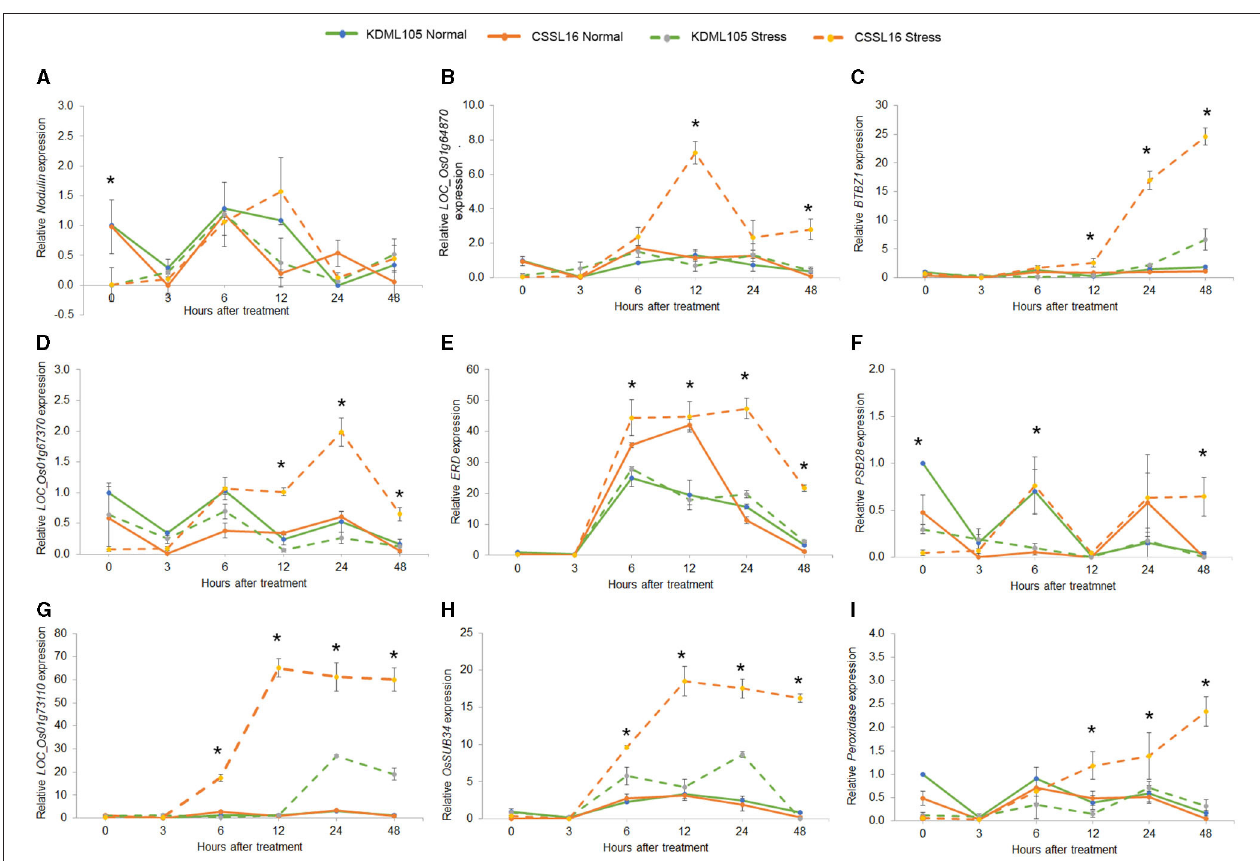
FIGURE 9 | Gene expression analysis of nine candidate genes, Nodulin (A) , Os01g64870 (B) , BTBZ1 (C) , Os01g67370 (D) , ERD (E) , PSBS28 (F) , Os01g73110 (G) , Sub34 (H) , and Peroxidase (I) in CSSL16 and KDML105 under normal and salt stress conditions after 0, 3, 6, 9, 12, 24, and 48h of salt stress. *indicates the significant difference among mean of the gene expression at p <